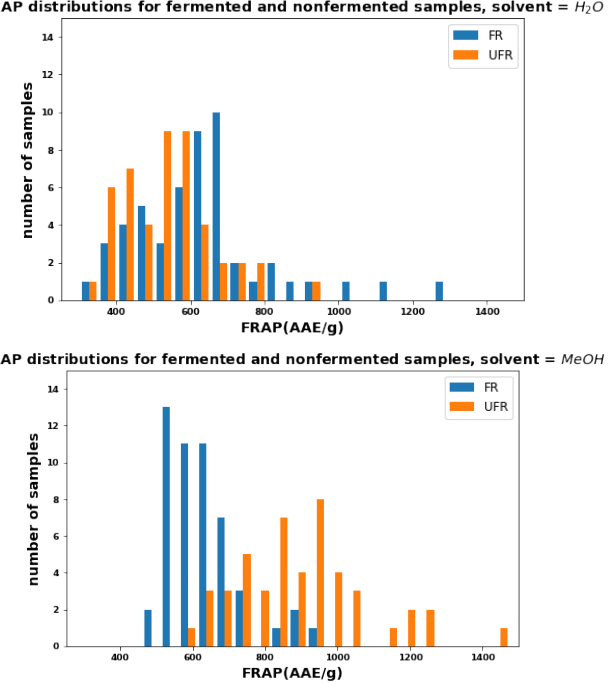
Figure 5. Distributions of FRAP for FR and UFR using water ( top ) and methanol ( bottom ) as solvents. FRAP for FR has similar characteristics as TPC and TEAC (Figure 6). However, the FRAP for UFR shows a much wider range of values for methanol and a narrower range for water. The overlap between FR and UFR regions is small.